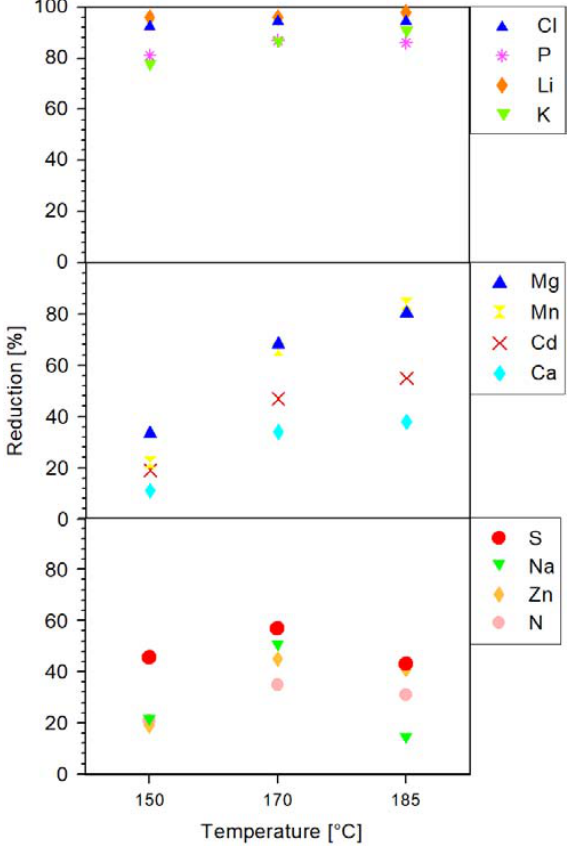
Figure 2. Elements assigned to three different groups according to their leaching behavior.